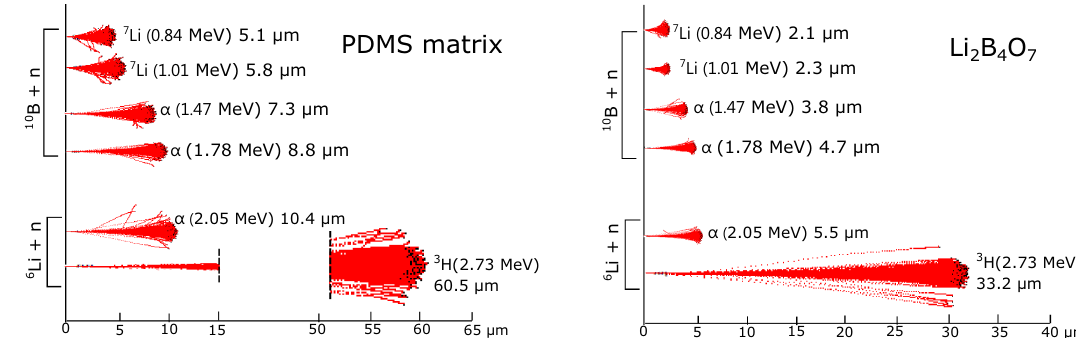
Figure 8. Simulated paths range on the polydimethylsiloxane matrix and on a LiBO target of the daughter products coming from the 6 Li and 10 B thermal neutron reaction. The simulation has been performed using the code Transmission of Ions in Matter (TRIM) 39